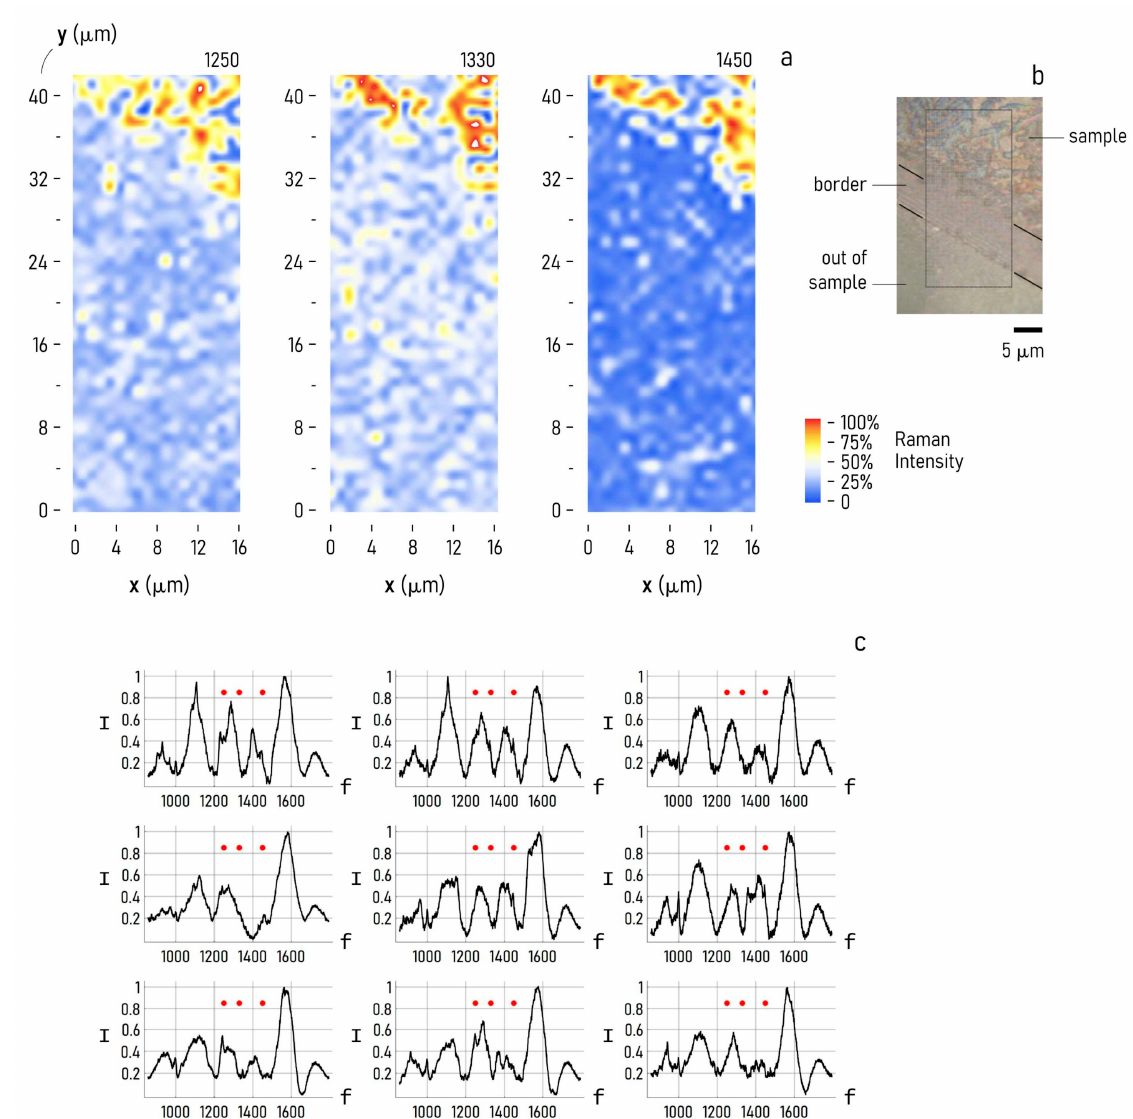
Figure 7. SERS maps of IgG positioned on the sensor device, acquired at 1250, 1330 and 1450 cm − 1 , respectively ( a ). Optical image of the sample drop after evaporation on the device, and the region of the sample surface interrogated through SERS analysis ( b ). Collection of nine spectra randomly sampled from the SERS maps, where the characteristic peaks of IgG have been highlighted ( c ).